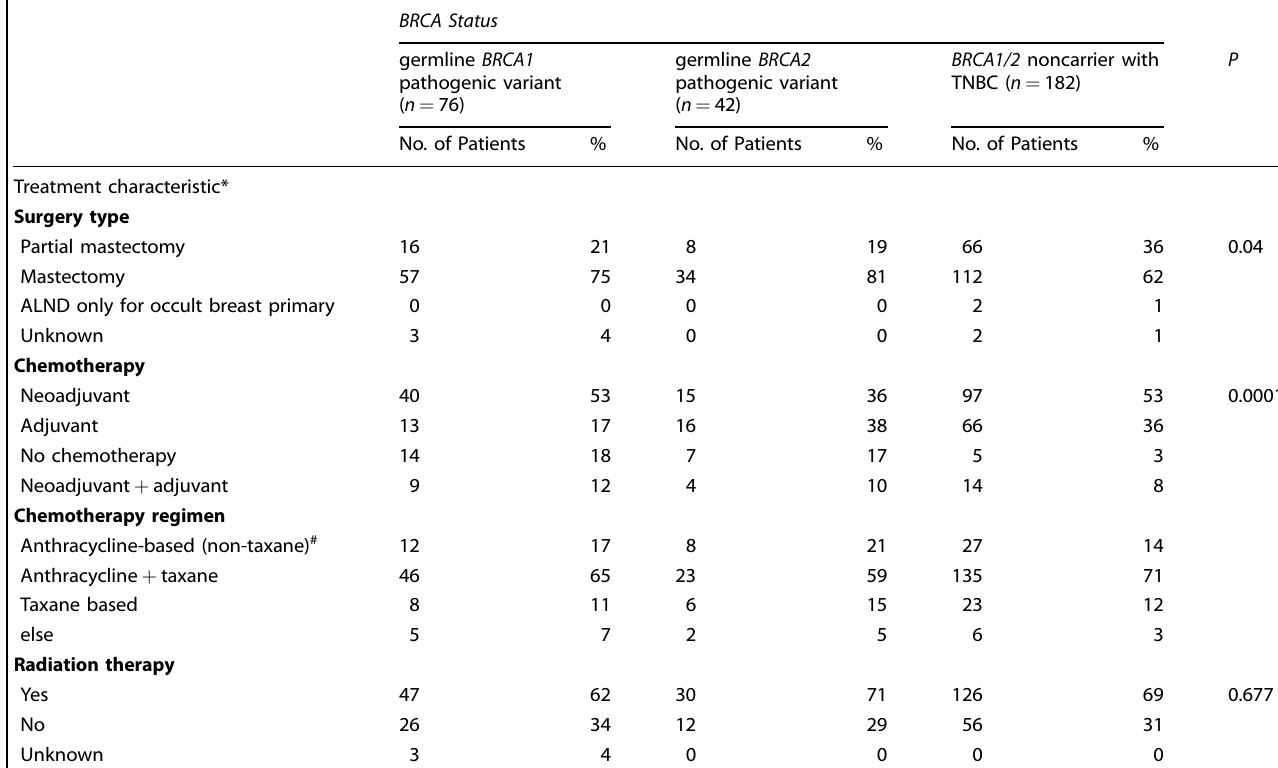
Table 2. Treatment characteristics of patients with distantly recurrent breast cancer by germline BRCA